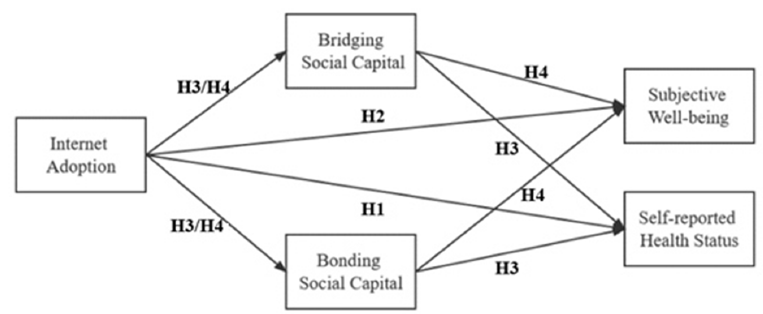
Figure 1. Conceptual framework.